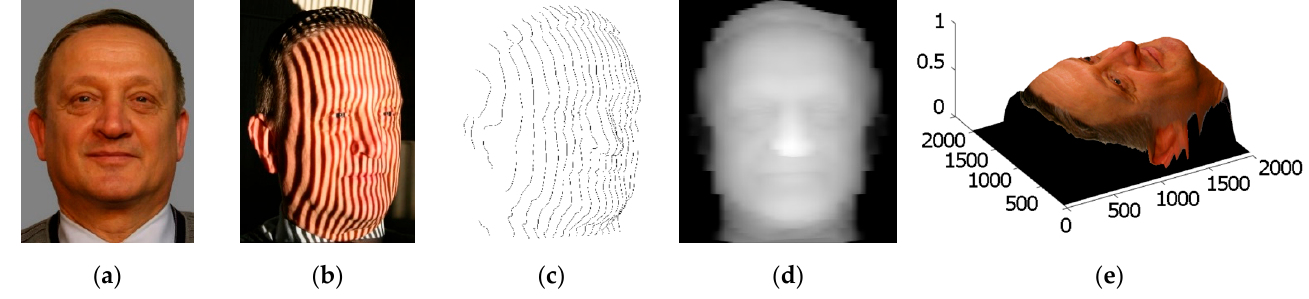
Figure 2. Initial frames of digital processing: ( a ) RGB image of the scene to be holographed (texture); ( b ) the image of the scene to be holographed, with the projection of structured fringes superposed on the holographic object; ( c ) the selected fringe array; ( d ) transformation of the horizontal shift to deep grey (depth map); and ( e ) virtual 3D model of the holographic object.